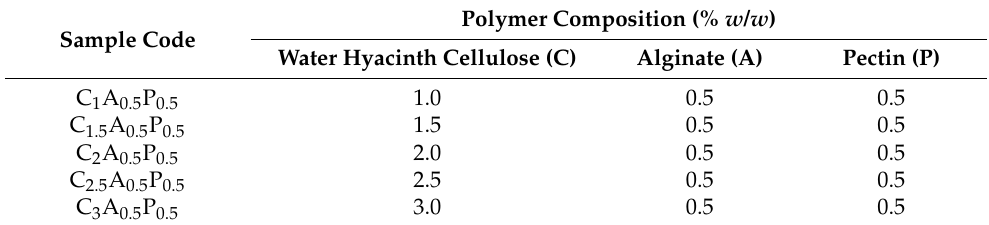
Table 4. Polymer compositions of water hyacinth cellulose-composited